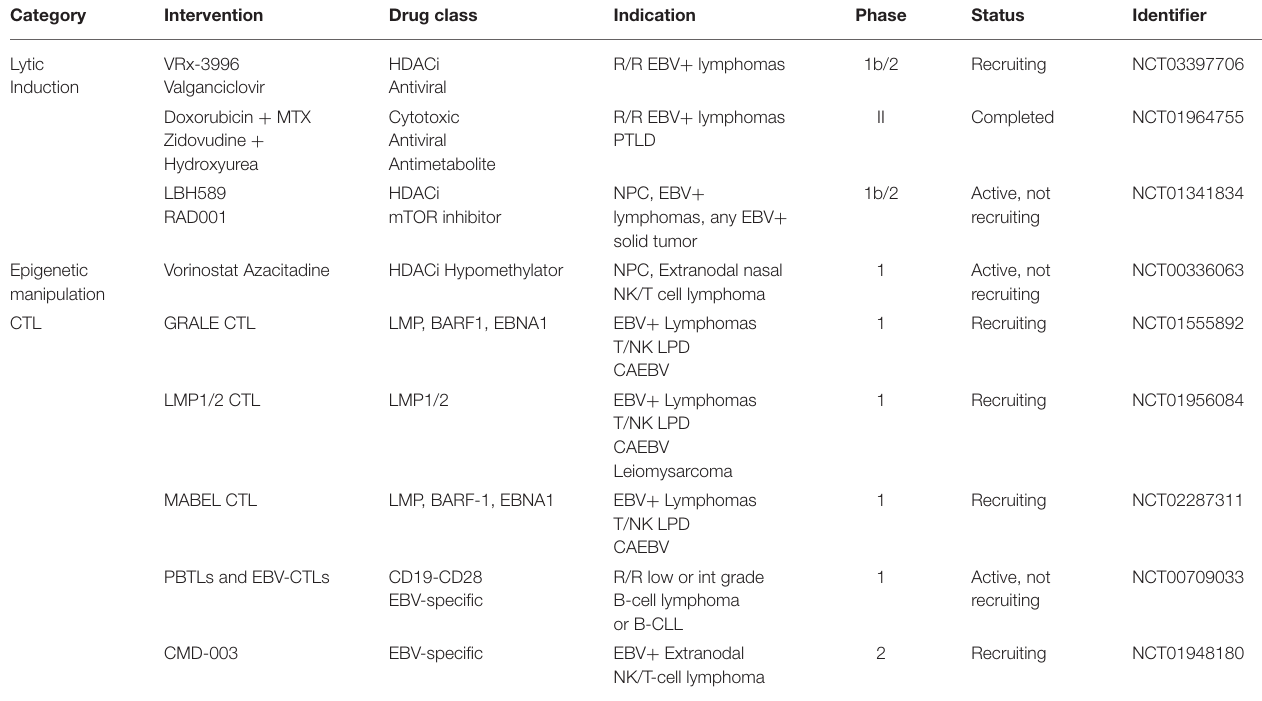
TABLE 2 | Clinical trials targeting EBV in